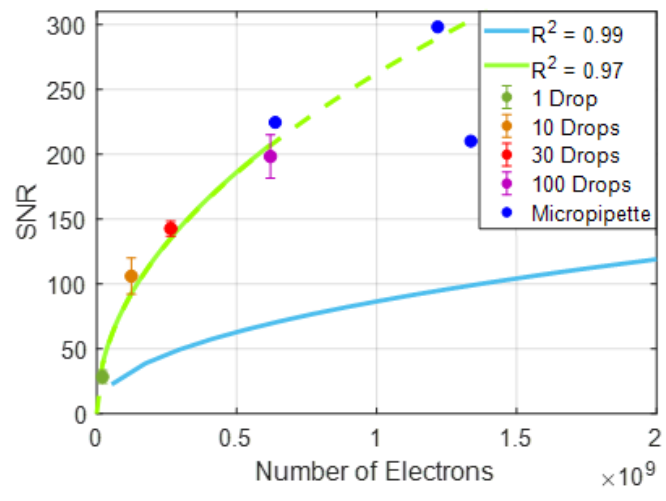
Figure 6. Comparison of the SNR levels obtained from MCP-2 functionalized chips. Averaged identical robotic spots (blue—previously shown), robotic spots of increasing size, and micropipette spots, with respect to the total number of electrons collected from the spots. The SNR behavior of larger robotic spots is also fitted to a square law curve (green).